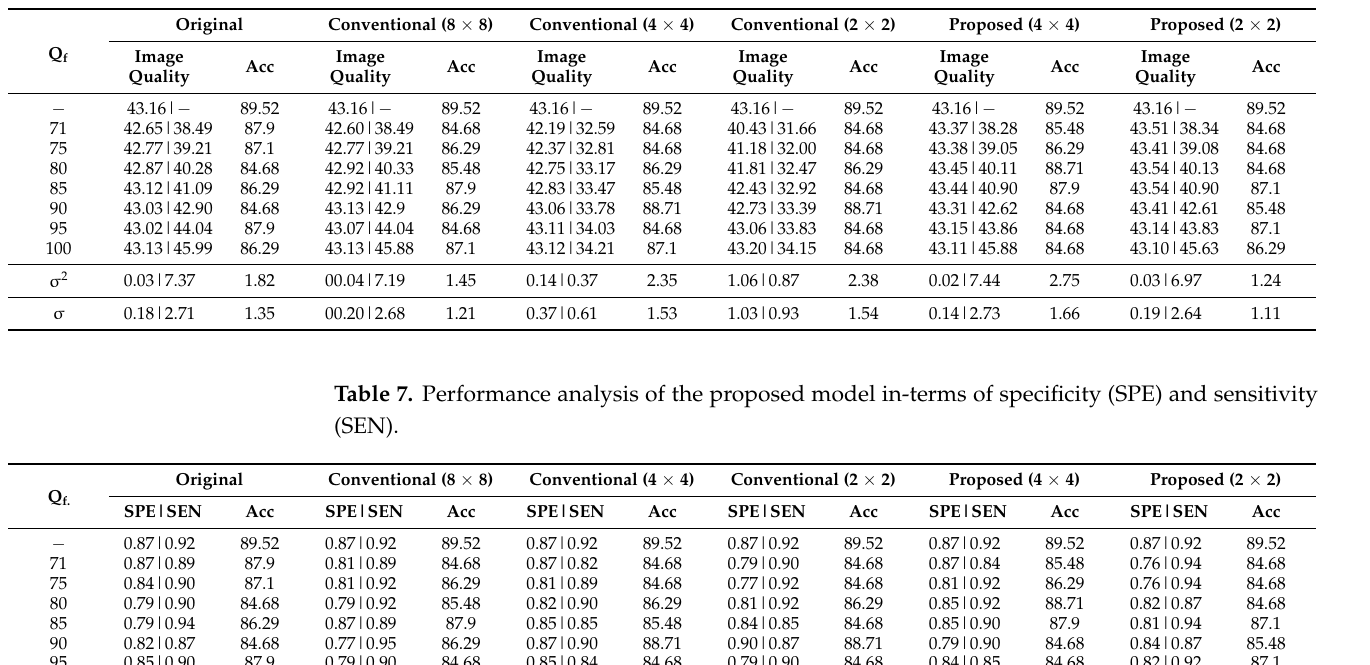
Table 6. Robustness analysis of the proposed model against different types of distortions resulted by the JPEG compression of plain and cipher images. Image quality is PIQUE|MS-SSIM, Acc is classification accuracy (%), σ 2 is variance and σ is standard deviation.